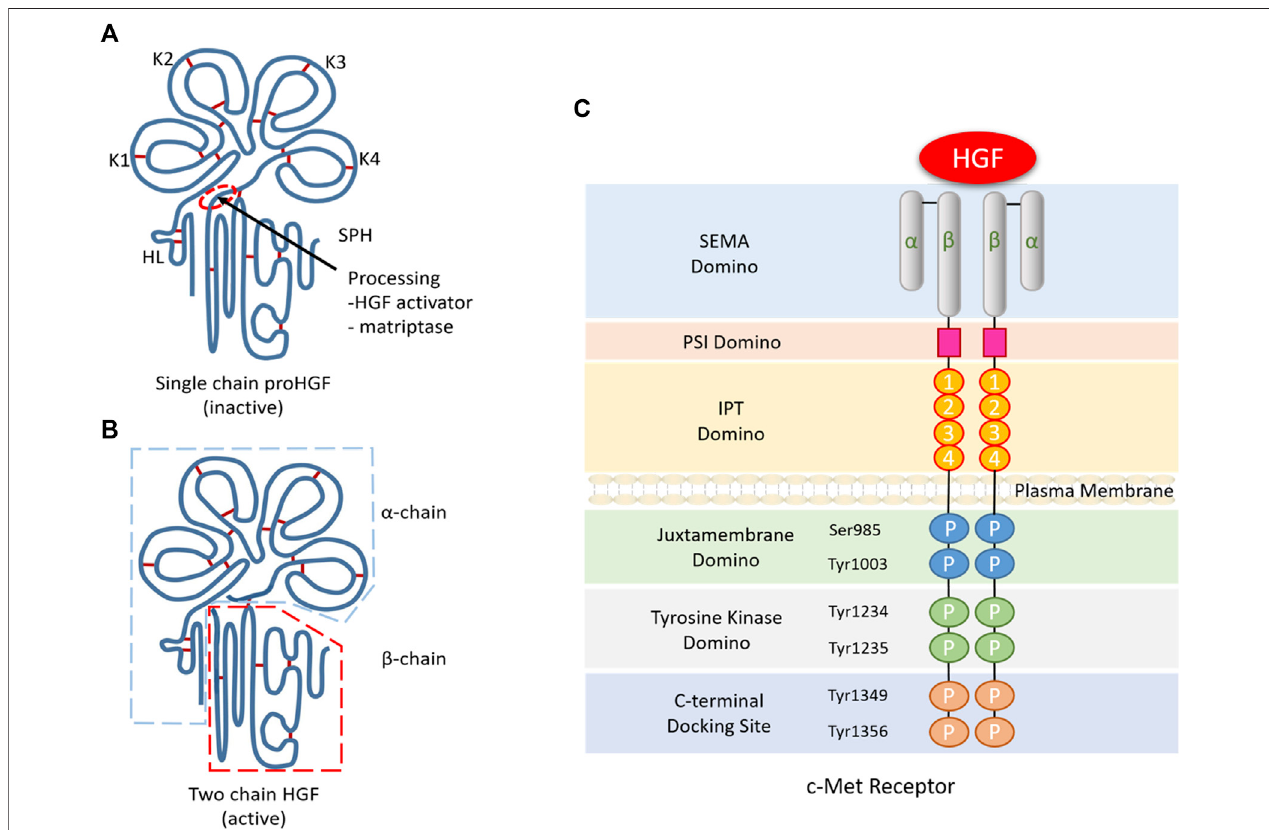
FIGURE 1 | Structure and molecular signalling components of HGF/c-Met. (A) . The α -chain of HGF is composed of an N-terminal hairpin loop (HL) attached four kringle domains (K1-K4), and the β -chain is composed of a serine protease homology domain (SPH) lacking proteolytic activity. (B) . Active HGF is a heterodimeric molecule composed of an α -chain and a β -chain. (C) . C-Met consists of a small α -chain and a larger β -chain, including extracellular, transmembrane and intracellular domains. The extracellular domain contains a large semaphore protein (SEMA) domain where HGF binds to c-Met. After the SEMA domain, a plexin, semaphorin and integrin-rich (PSI) domain and four immunoglobulin/plexin/transcriptional factors (IPT) domains make up the rest of the extracellular domains. Intracellularly, the C-terminal tail of c-Met β -chain containing two phosphorylation sites (Ser985 and Tyr1003), two tyrosine residues (Tyr1234 and Tyr1235) and a multisubstrate docking site (Tyr1349 and